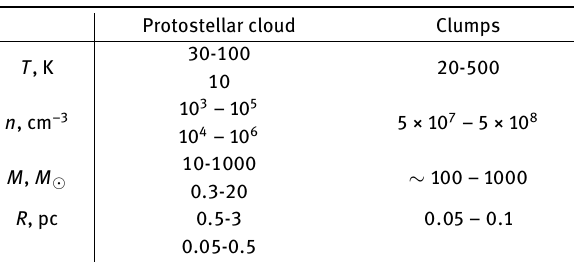
Table 3. Characteristics of the fragments found in simulations (col- umn 3) in comparison with the protostellar clouds’ properties (col- = 1.9 × 10 −4 G. 0 umn